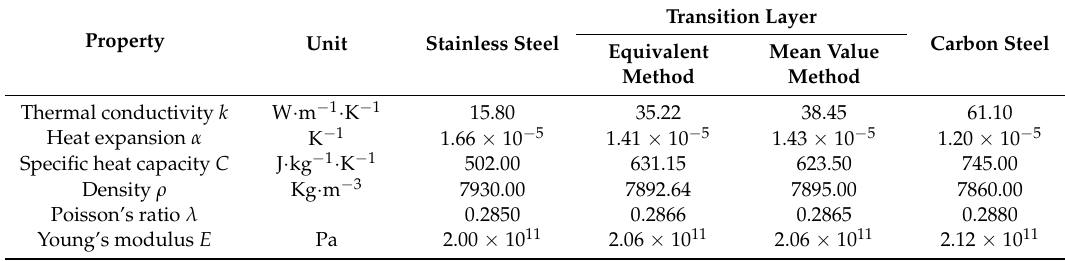
Table 3. Material properties of the